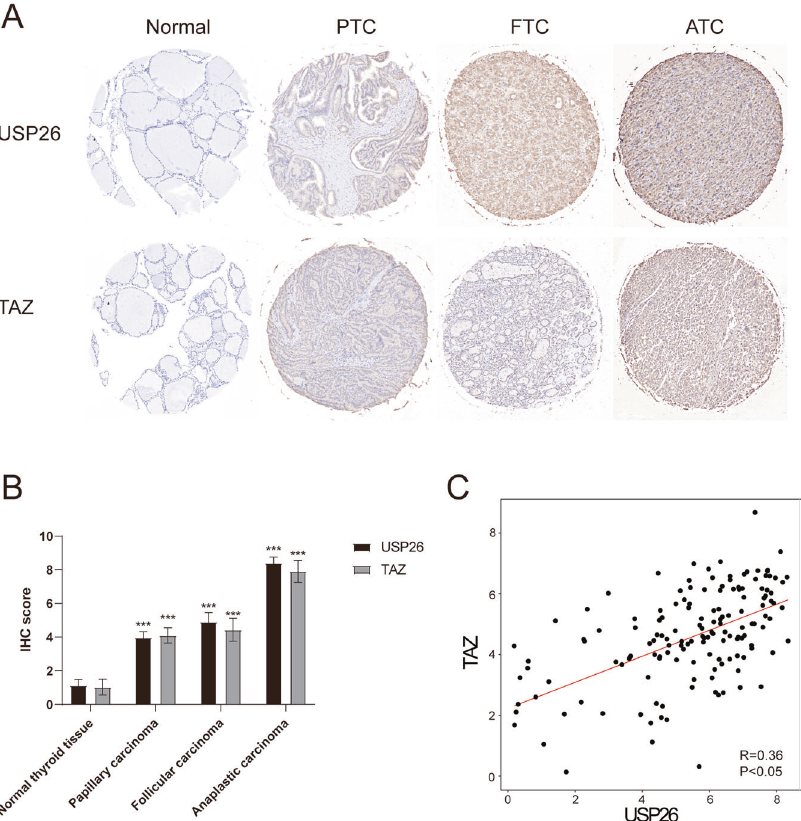
Fig. 7 USP26 correlates with TAZ protein levels in human thyroid cancer samples. A , B USP26 and TAZ was upregulated in ATC. C USP26 correlated with TAZ in thyroid cancer samples. Commercially available tissue microarray slides (Alenabio, China.) were purchased for IHC analysis. Each microarray contained 140 samples, including normal thyroid tissue ( n = 12), papillary thyroid carcinoma ( n = 63), follicular carcinoma ( n = 46), anaplastic carcinoma ( n =